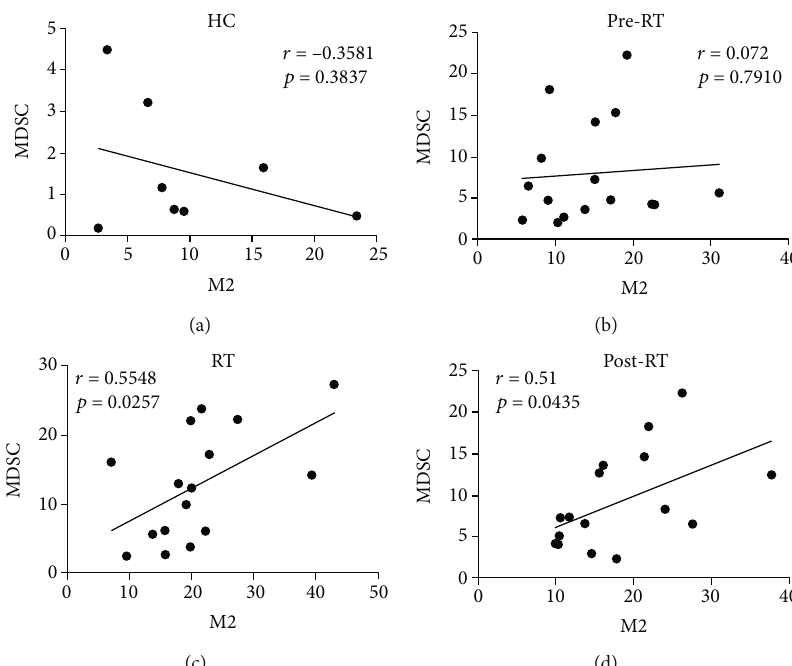
Figure 2: The correlation between peripheral MDSCs and CD68 + CD163 + M2-like macrophages in HC and NSCLC patients. (a) The relationship between peripheral MDSCs and CD68 + CD163 + M2-like macrophages in HC. The correlation between MDSCs and CD68 + CD163 + M2-like macrophages in NSCLC patients among (b) pre-RT, (c) RT, and (d) post-RT group. Data were analyzed by Pearson ’ s correlation